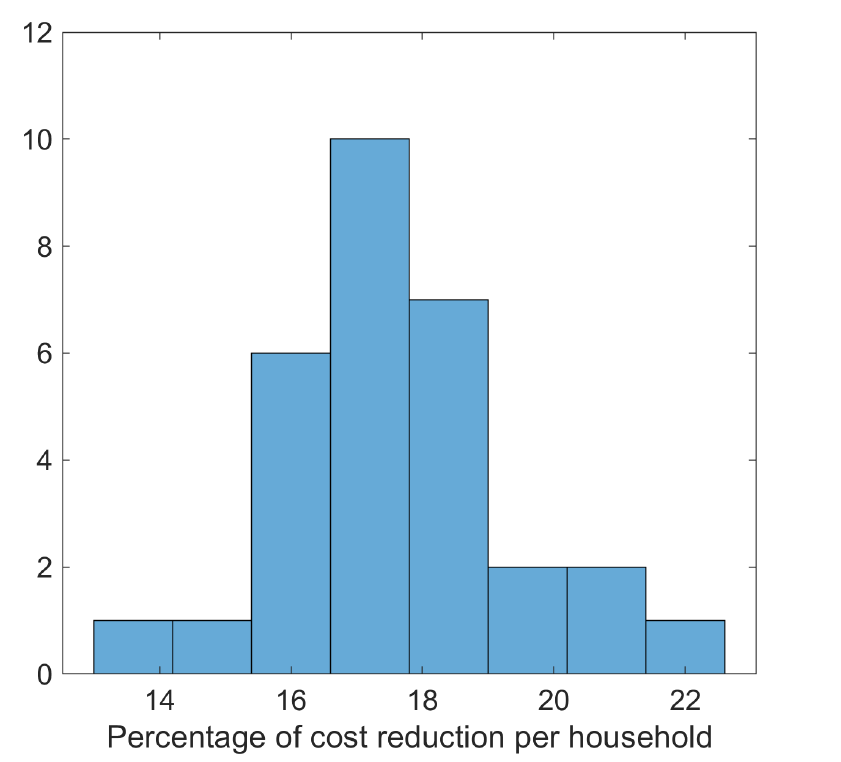
Figure 11. Histogram of the average cost reduction per household (in % and based on Equation (6), without standby mode and with the Reinforcement learning